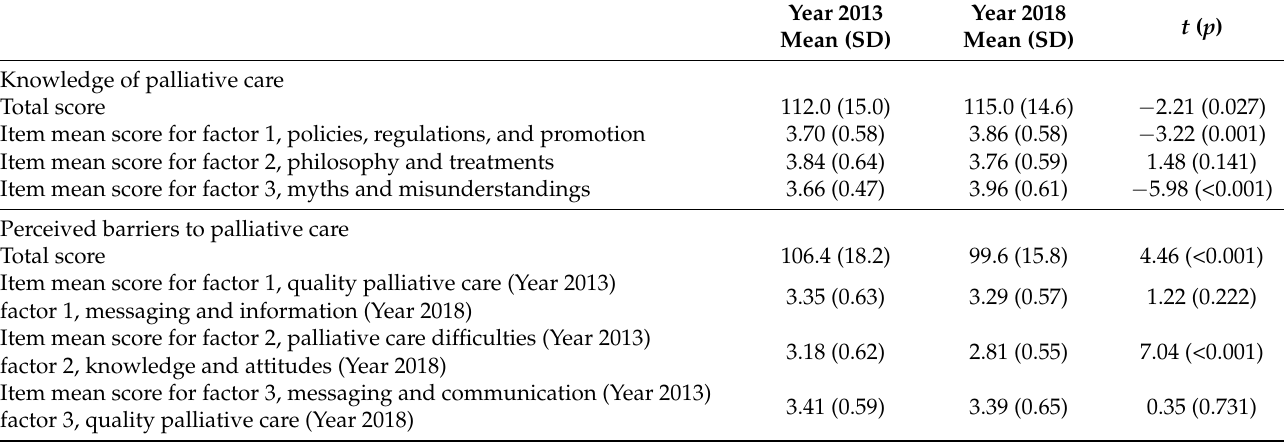
Table 6. Evaluations of mean scores of the total scale and the factors of knowledge of palliative care scale and perceived barriers to palliative care in 2013 and